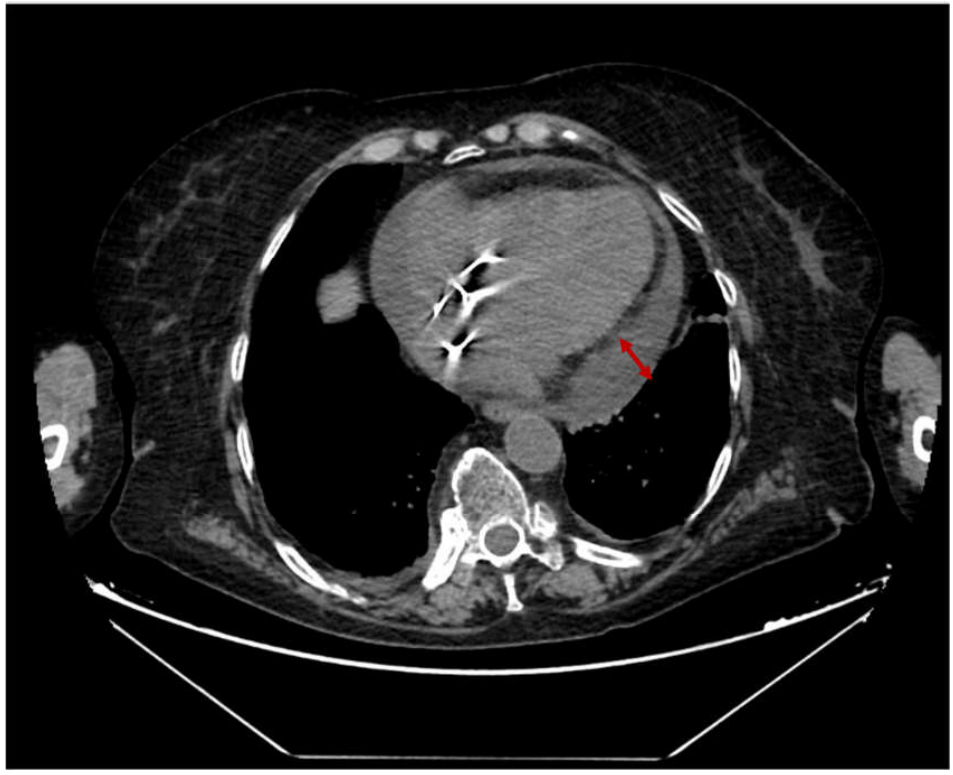
Figure 2. Thoracic CT-scan showing pericardial effusion ( Case 2 ) .